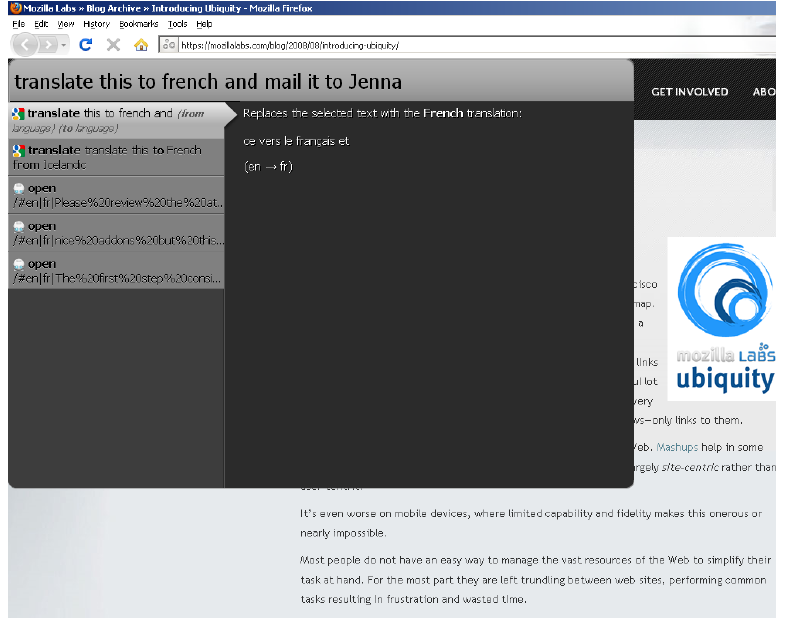
Figure 13. Example of user’s request using